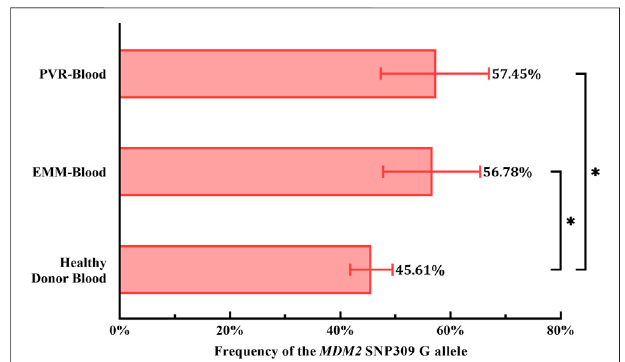
FIGURE5 | Comparison ofthe frequency ofthe MDM2 SNP309 G allele in blood samples. Overall, both cohorts of patients exhibited a higher frequency of the G allele than healthy Chinese donors. 95% CI, 95% con fi dence interval; EMM, epimacular membrane; MDM2, mouse double minute 2 gene; PVR, proliferative vitreoretinopathy; SNP, single nucleotide polymorphism. Asterisks indicate statistical signi fi cance upon comparison: * p < 0.05. Data are presented as the frequency of the MDM2 SNP309 G allele ±95%